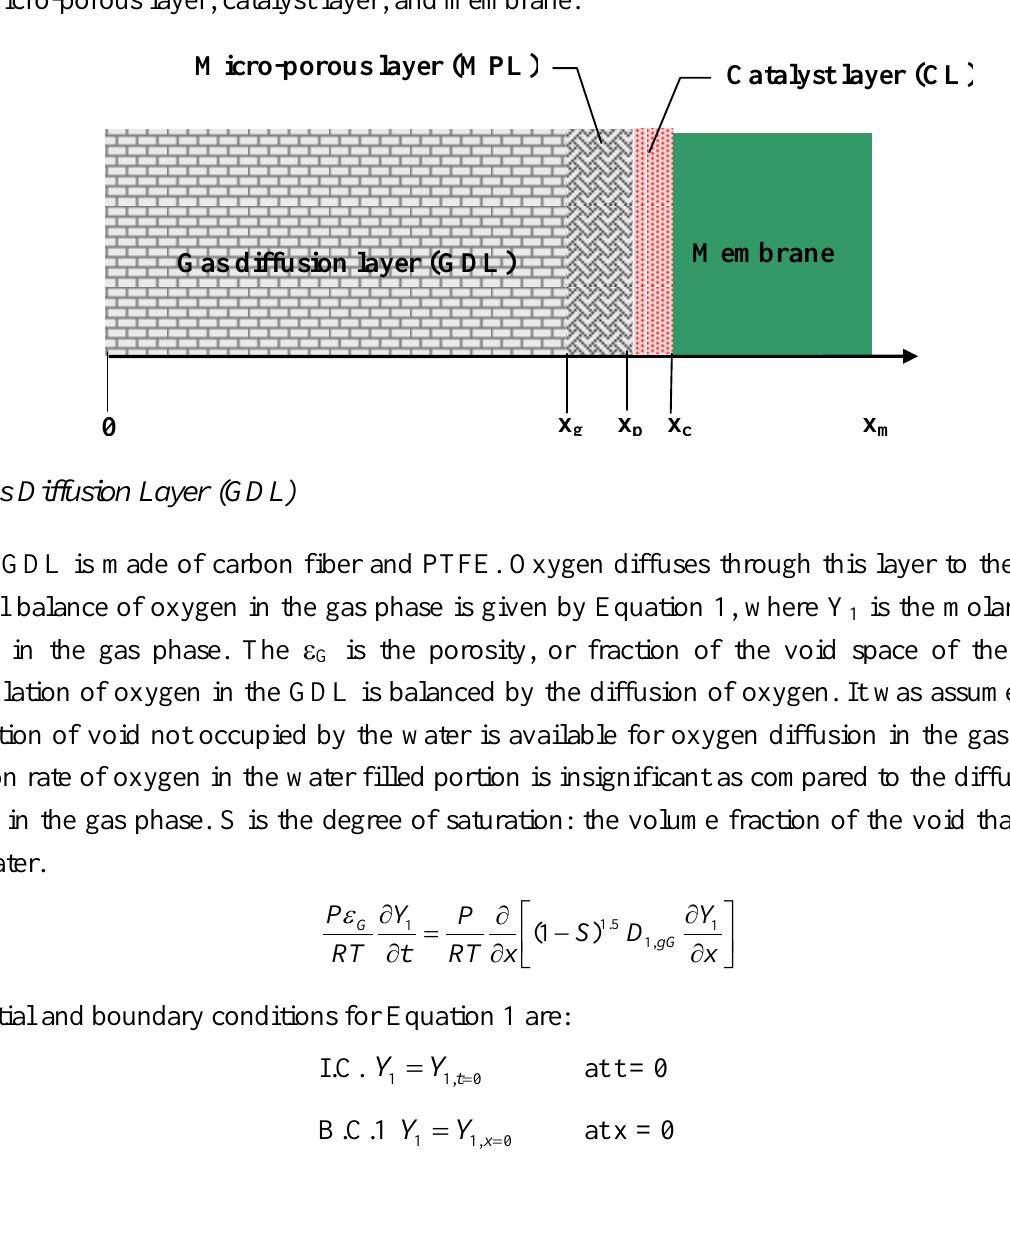
Figure 1. Components considered in this model. They are gas diffusion layer, micro-porous layer, catalyst layer, and